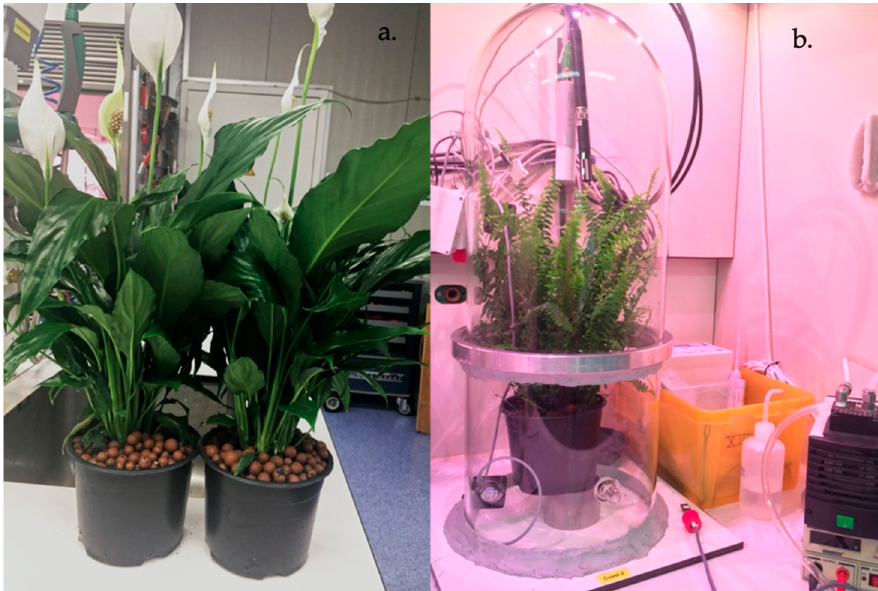
Figure 2. Selected plants: ( a ) Spathiphyllum Wallisii Regel (common name: peace lily); ( b ) Nephrolepis exaltata L. (common name: Boston fern) in the glass container.